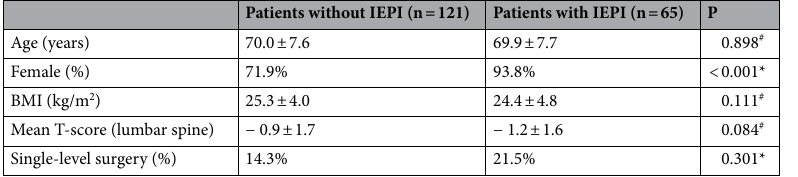
Table 3. Comparison of the patient data between the IEPI group and no-IEPI group. BMI body mass index, NS not significant. # Student’s t-test was performed. *Chi-squared test was performed.